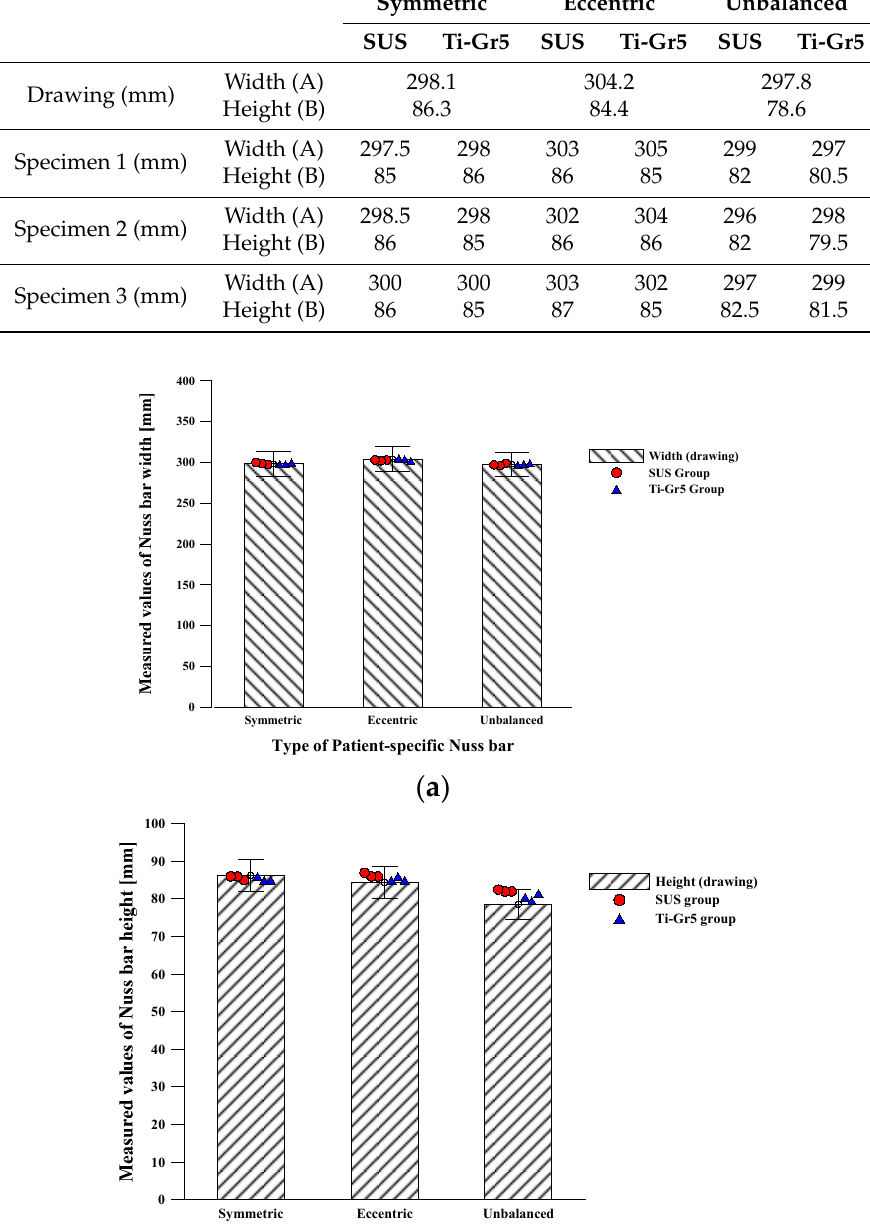
Table 8. Data table for patient-specific Nuss bar dimension accuracy.